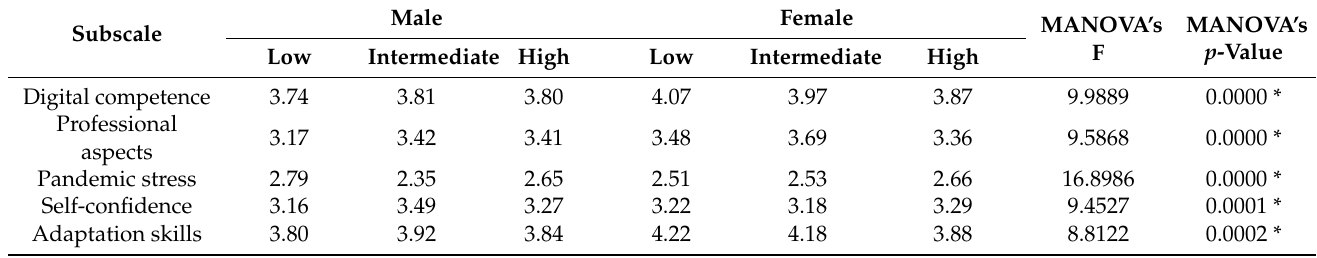
Table 6. Mean values differentiated by gender and MANOVA test statistics.